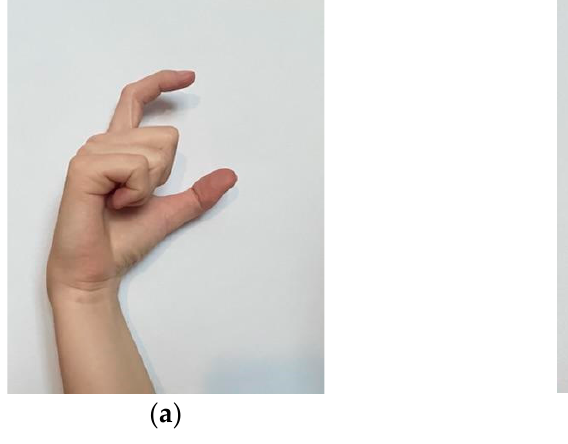
Figure 8. Letter C ( a ) and letter L ( b ) in Polish sign language. Table 1. Combinations of parameters that must be satisfied for every letter. Max—finger bent max- imally; Mid—finger slightly bent; Min—straight finger. The accelerometer column shows whether usage of the accelerometer is necessary for the finger. Blue color indicates the letters that are not easily identified (more in Section 4, Discussion).